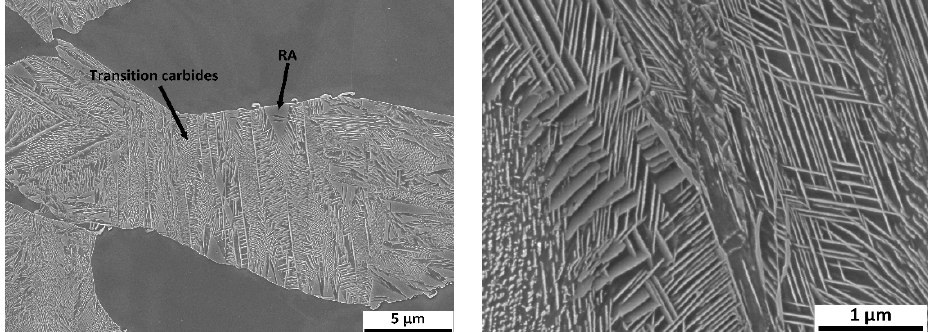
Figure 18. Microstructure during the tempering of heat A with 5 wt% Al. Tempering temperature